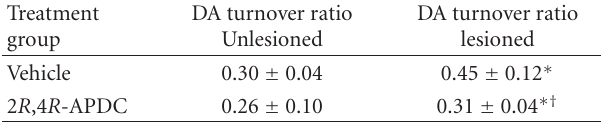
Table 2: Measurement of striatal dopamine metabolism in the unlesioned and lesioned striata in each treatment group. Data are expressed as mean dopamine turnover ratio ± s.e.m calculated by the expression (DOPAC + HVA/DA) using mean pmol/mg wet weight tissue values for DA, DOPAC, and HVA, respectively. ∗ P < . 05, unlesioned versus lesioned hemisphere. † P < . 05, 2 R ,4 R -APDC versus vehicle-treated animal [10]. Drug concentrations in nmol (final injection volume 4 μ